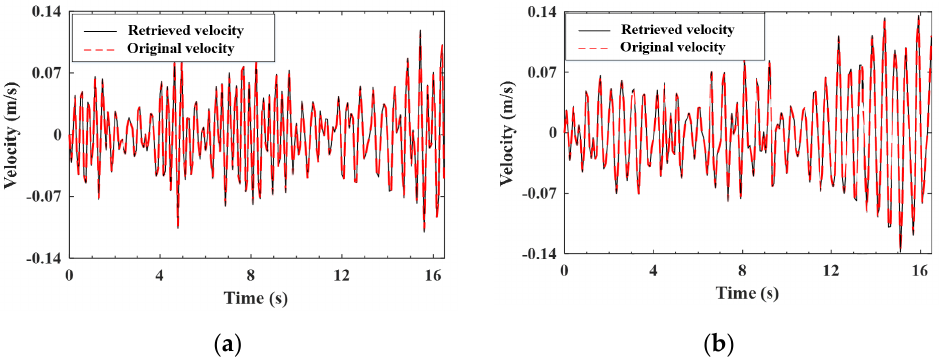
Figure 5. Retrieved and original velocity responses of the test vehicle (Class A roughness). ( a ) front axle; ( b ) rear axle.